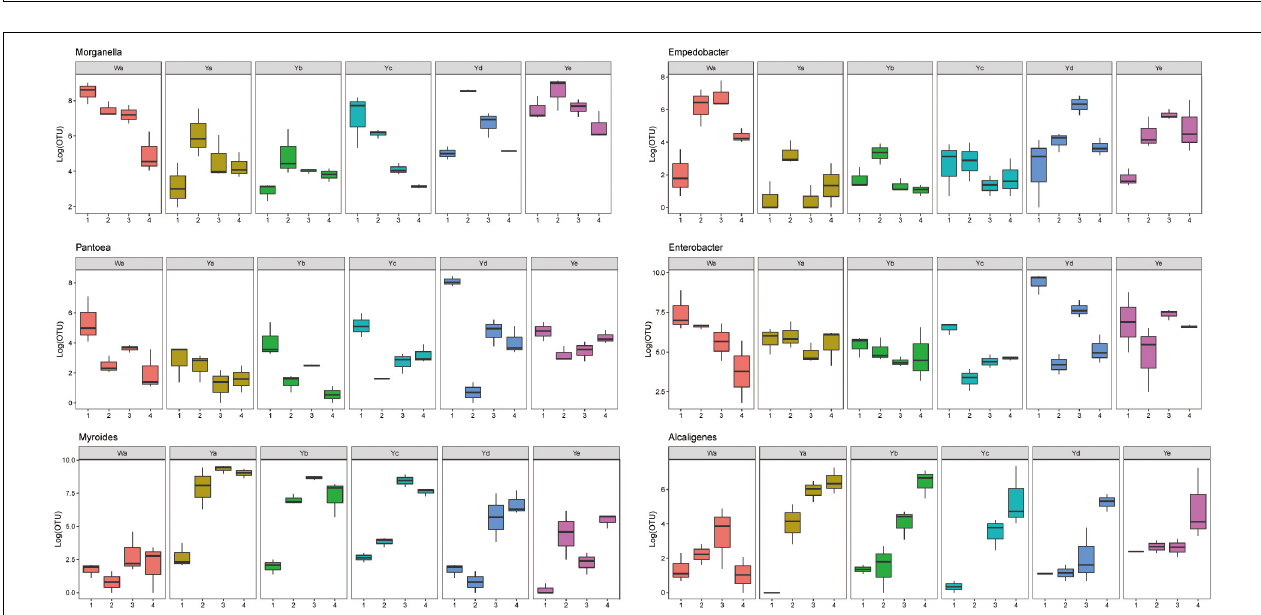
FIGURE 4 | Heat maps of the relative abundances and distributions of bacterial genera in housefly larvae. The heatmap illustrates the relative percentage of each genus in each sample. The color code indicates the relative abundance, ranging from faint (low abundance) to intense (high abundance). Each treatment included three biological replicates. Wa, Ya, Yb, Yc, Yd, and Ye represent housefly larvae samples fed diets with sterile water, P. aeruginosa stock solution, and the stock solution diluted 10 2 , 10 4 , 10 6 , and 10 8 fold, respectively.